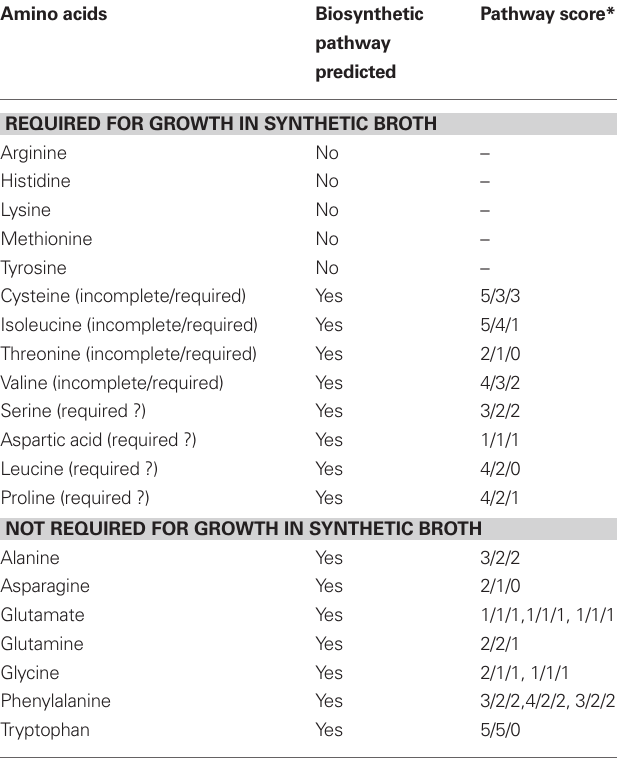
Table 1 | Nutritional requirements of F. tularensis